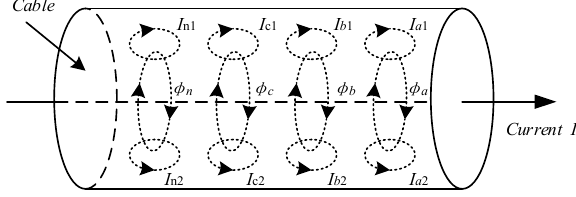
Figure 1. Schematic diagram of eddy current.